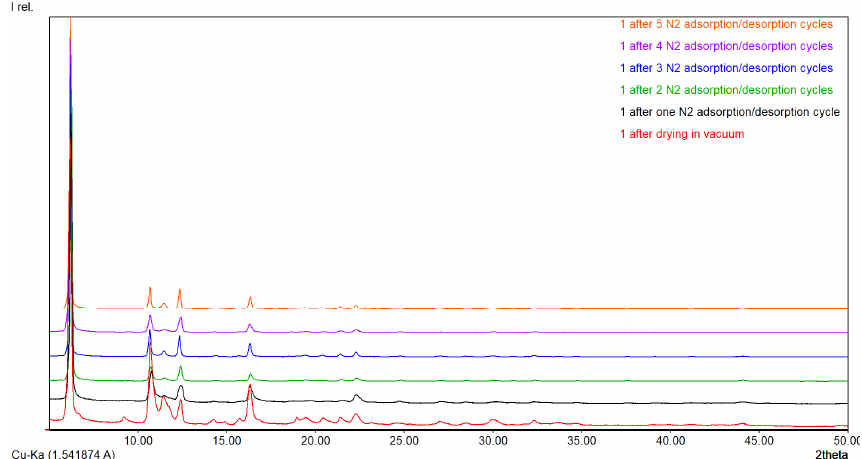
Figure 10. Diffractograms corresponding to compound 1 after drying in vacuum (red) and after 1 (black), 2 (green), 3 (blue), 4 (purple) and 5 (orange) N 2 adsorption/desorption cycles.